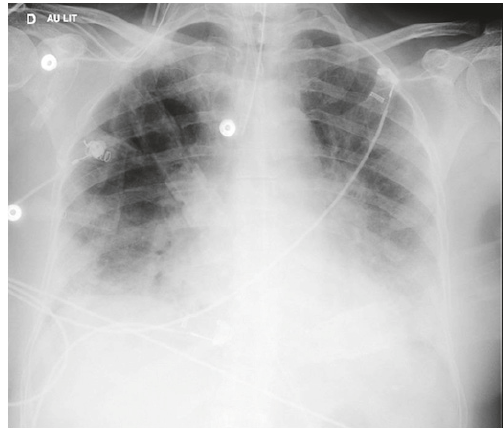
Figure1:ThechestX-ray(insupineposition)onadmissionshowing bilateral alveolar-interstitial syndrome with bilateral lower lobe